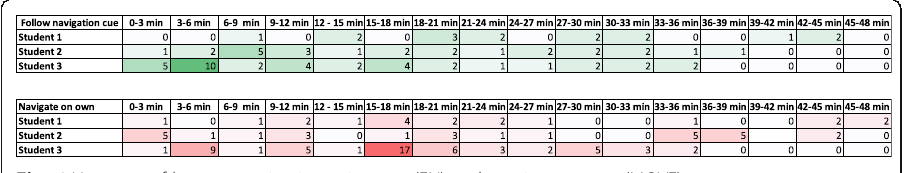
Fig. 6 Heatmap of learners navigating using cue (FN) and moving on own